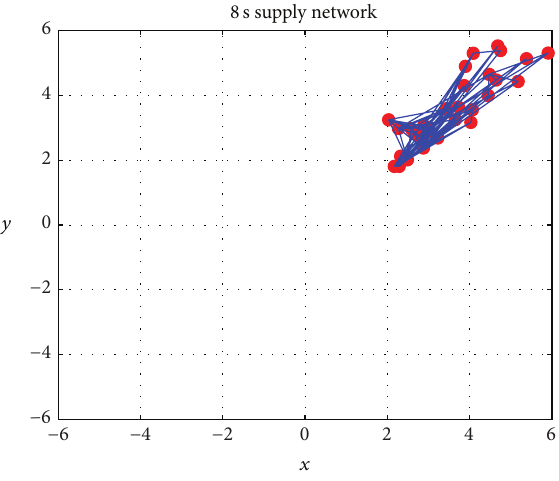
Figure 8: Evolution results of number 5.